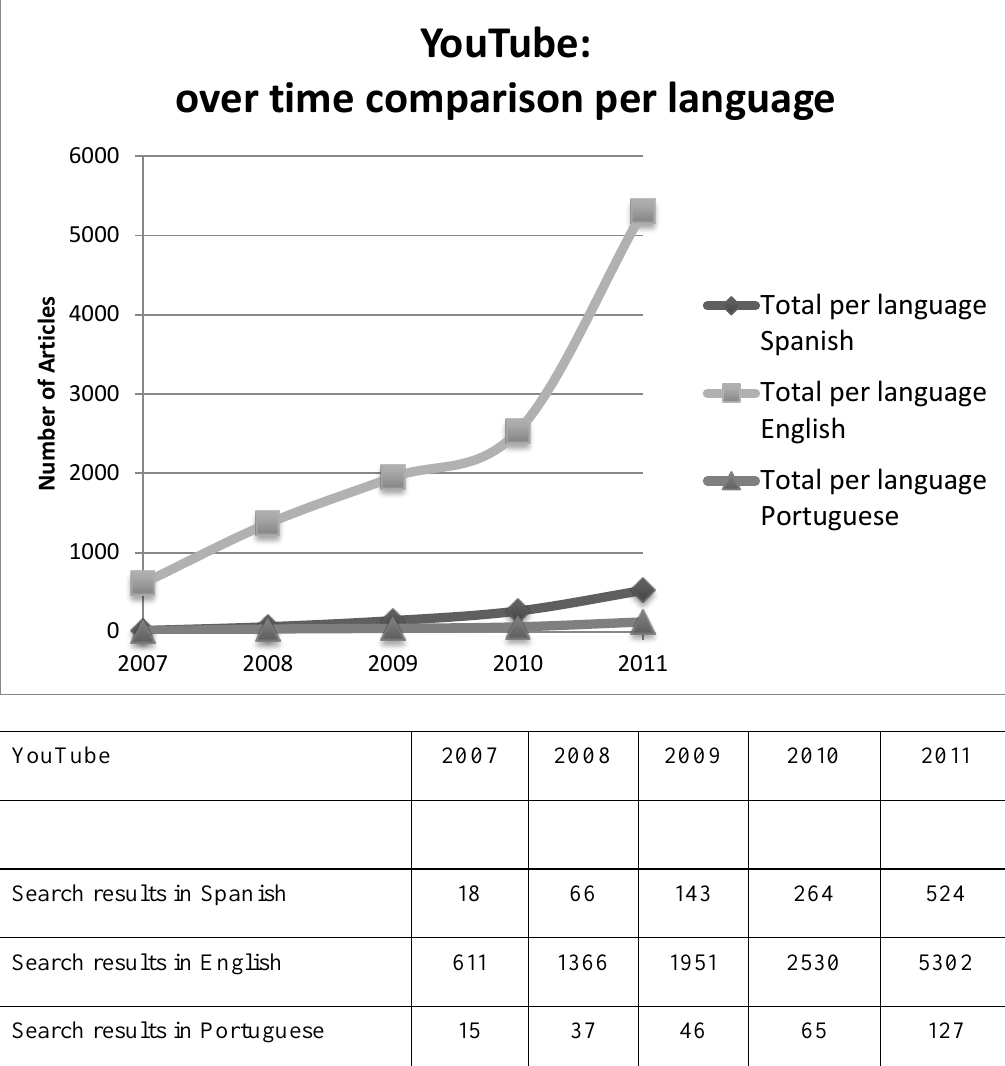
Figure 4 . YouTube: Over time comparison per language .